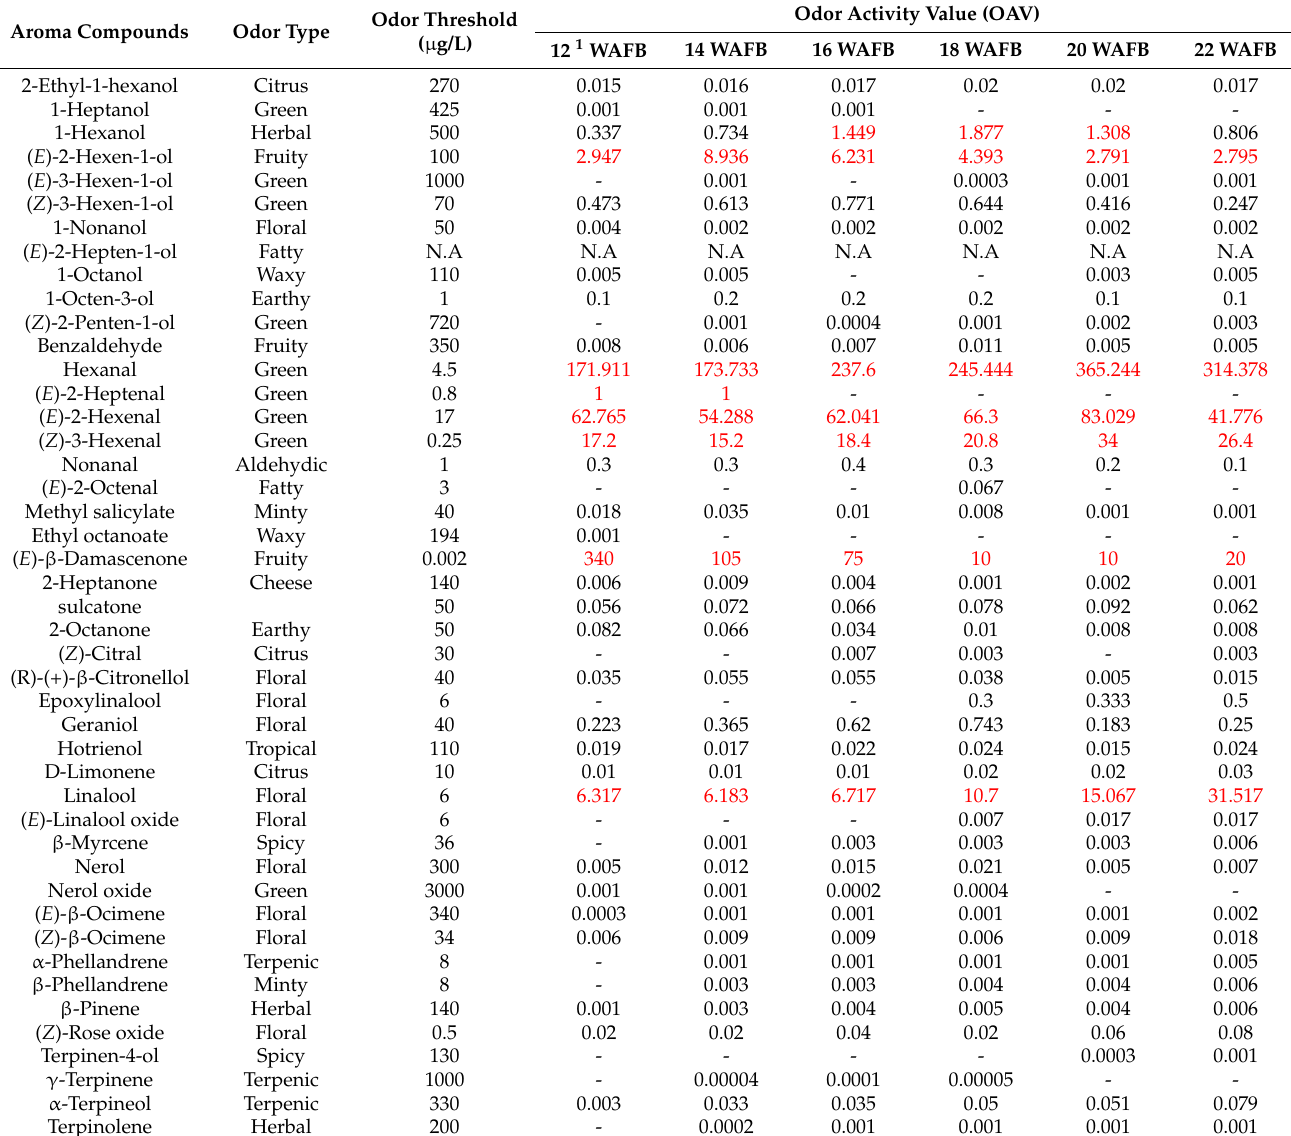
Table 3. Odor thresholds, description, and activity values of volatile free aroma